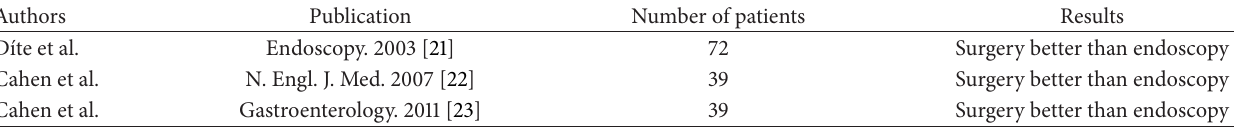
Table 2: Randomized controlled studies comparing endoscopic and surgical treatment of painful CP.